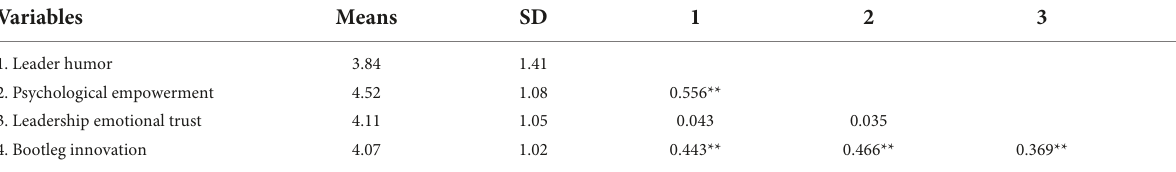
TABLE 2 Means, standard deviations, and pearson correlation coefficients of the main variables. Variables